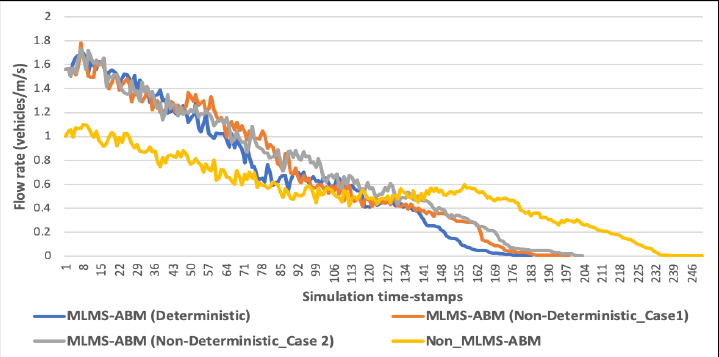
Figure 13. Traffic flow during simulation time (real-world network).